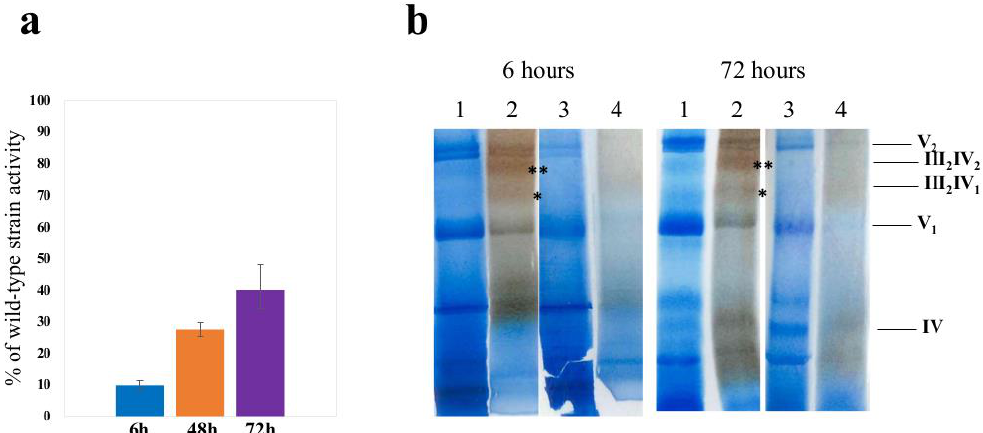
Figure 1. Cytochrome c oxidase activity and supercomplex formation before and after adaptation of yeasts to respiratory growth. ( a ) CIV activity in mitochondria isolated from aim23 ∆ after 6, 48, and 72 h of cultivation on YPEG, expressed in percent of wild-type activity (measured at the same time points) ± SD. ( b ) Blue native PAGE analysis of mitochondria isolated from wild-type ( 1,2 ) and aim23 ∆ (3,4) strains. Approximately, 100 µ g of mitochondria were digitonin-solubilized and applied on 4–10% Blue native PAGE. After electrophoresis, the gel was sliced for tracks that were additionally stained with Coomassie G250 (1, 3) or for CIV activity (2, 4). (*) and (**) signs for CIII(2)CIV(1) and CIII(2)CIV(2) positions, respectively; supercomplexes, CV, and CIV positions are indicated.